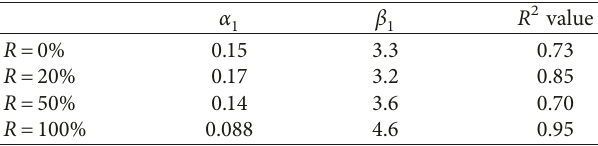
Table 1: Coefficients of (19) for carbonation rate estimation in RACs.